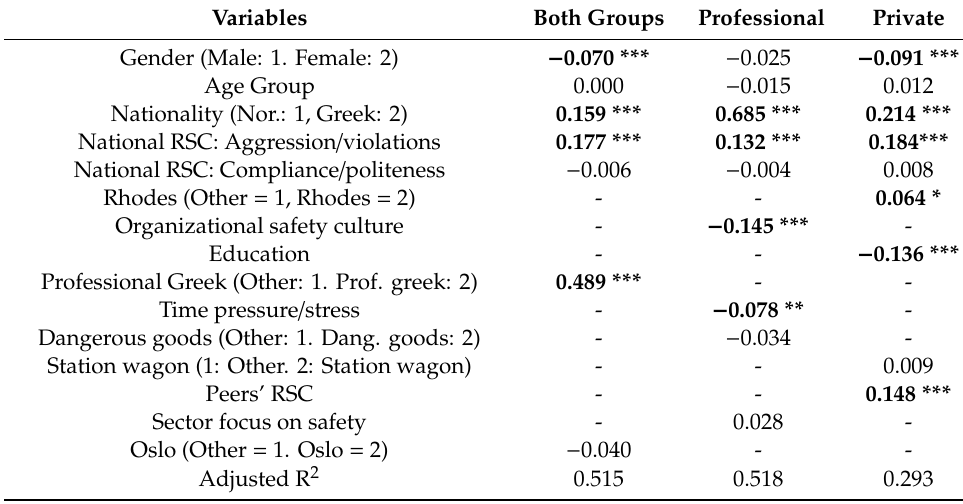
Table 12. Linear regression analyses for three groups. Dependent variable: “Drive without a seat belt”. Standardized beta coe ffi